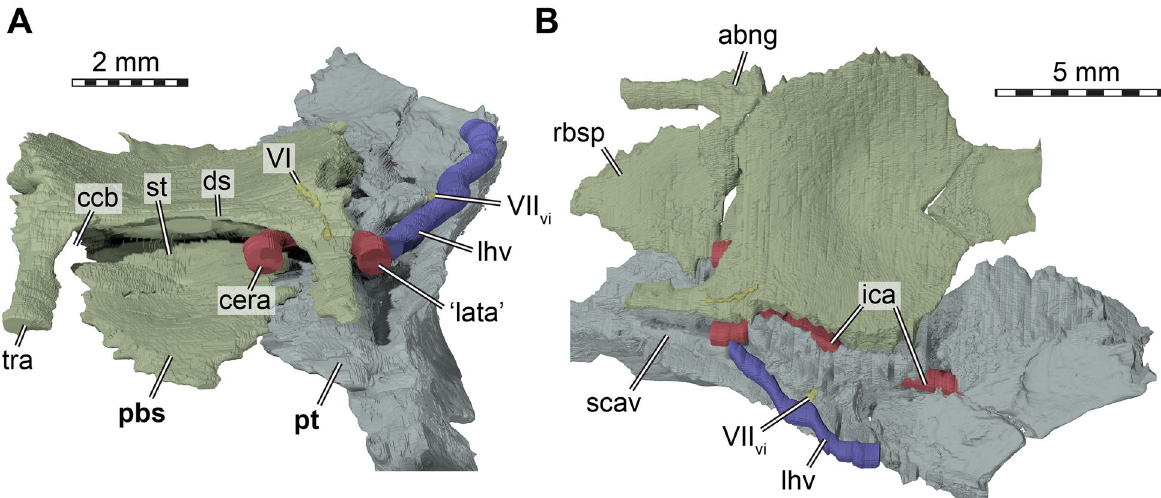
Fig. 9 Three dimensional renderings of the partial basicranium of Plastomenus thomasii (AMNH FR 6015) with reconstructed arteries and nerves. A anterodorsal view onto parabasisphenoid and left pterygoid; B dorsal view. Note that bones are labelled in bold. Nerves are reconstructed in yellow, arteries in red, and veins in blue. abng abducens nerve groove, ccb canals caroticus basisphenoidalis, cera cerebral artery, ds dorsum sellae, ica internal carotid artery, ‘ lata ’ lateral artery (possible palatine artery or pseudopalatine artery or mandibular artery), lhv lateral head vein, pbs parabasisphenoid, pt , pterygoid, rbsp rostrum basisphenoidale, scav sulcus cavernosus, st sella turcica, tra trabecula, VI abducens nerve, VII vi vidian branch of facial